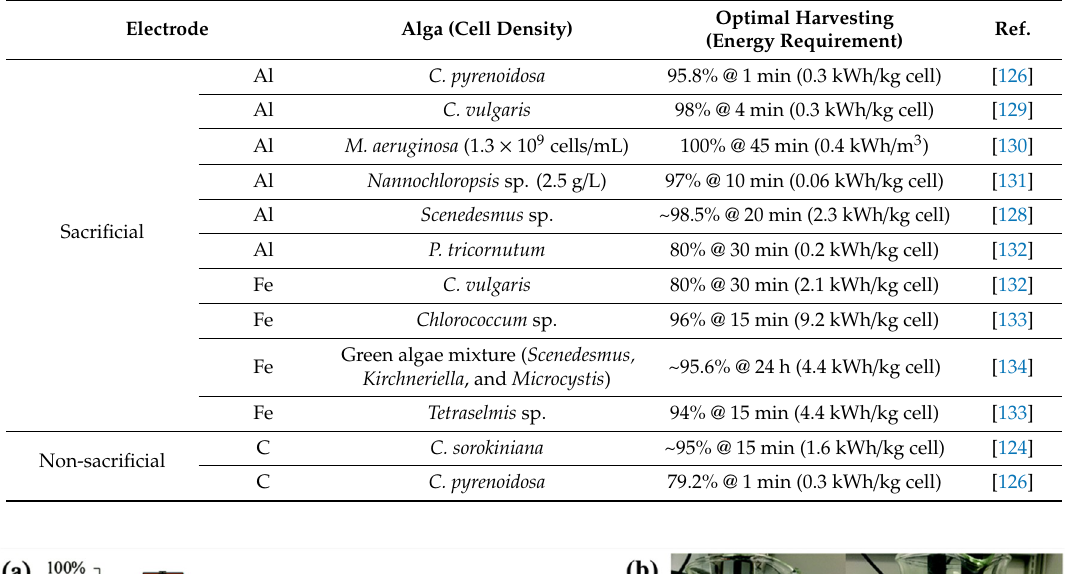
Table 5. Comparison of sacrificial and non-sacrificial electrodes for algae harvesting.